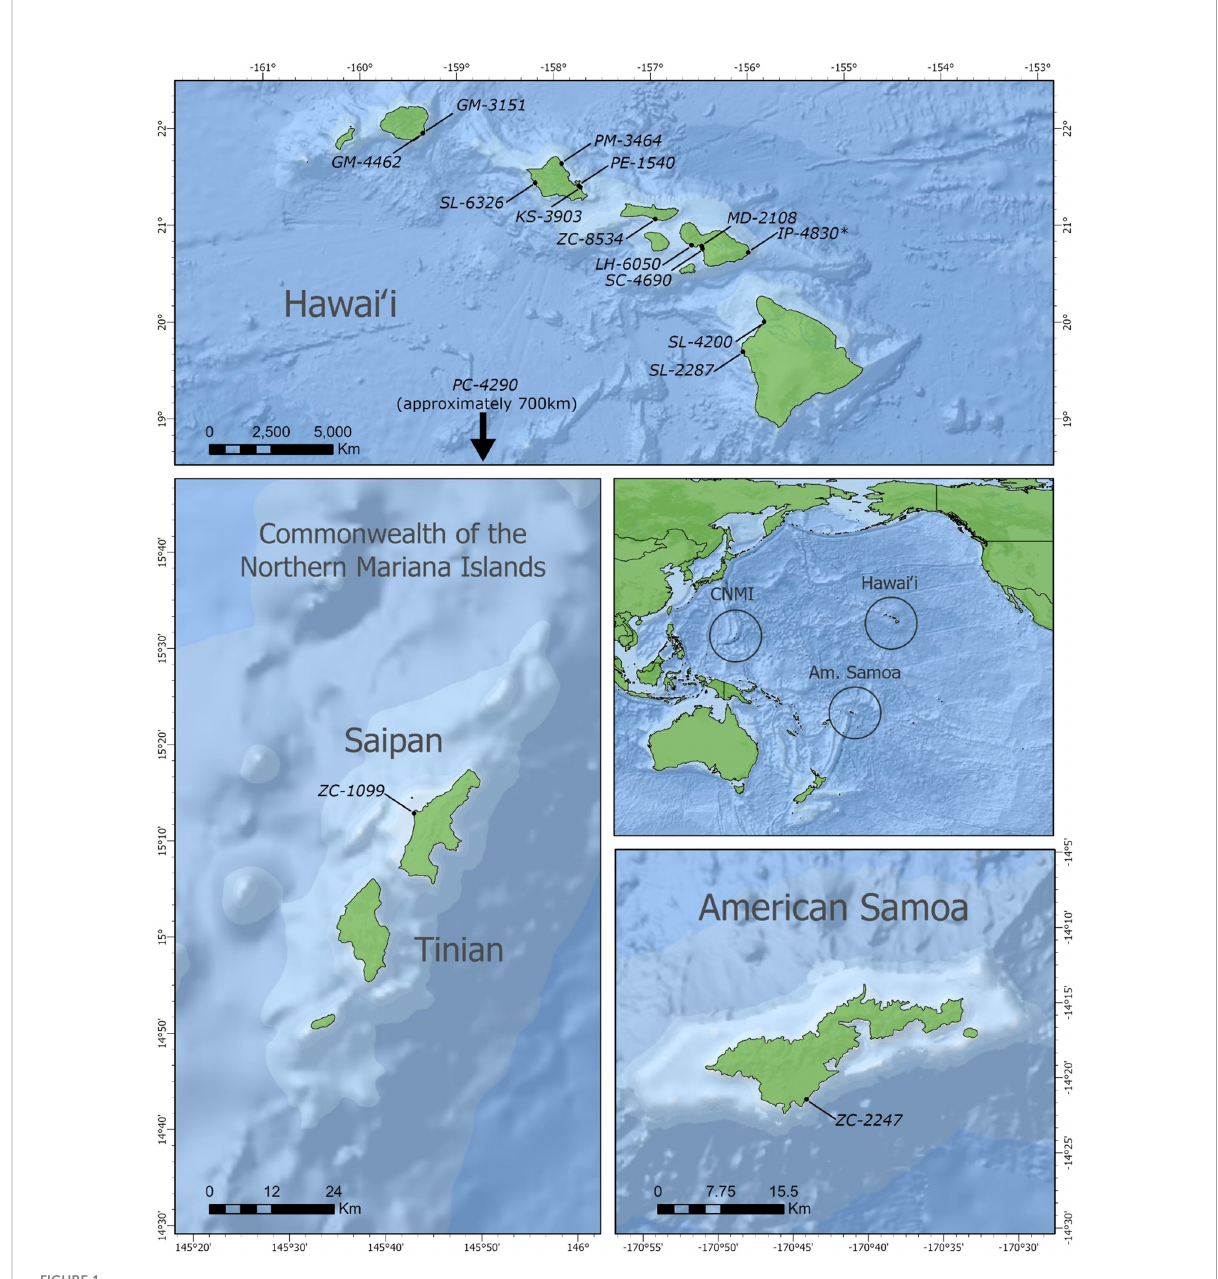
FIGURE 1 Stranding locations of beaked whale circovirus positive animals. Hawaiian Islands (n=13, *initial Longman's beaked whale); Saipan (n=1); American Samoa (n=1). Location of open ocean by-caught false killer whale not pictured. Base map source: ESRI, GEBCO, NOAA, National Geographic, DeLorme,